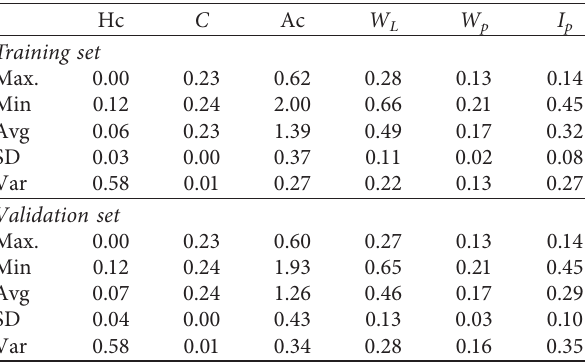
Table 2: Statistical analysis of collected